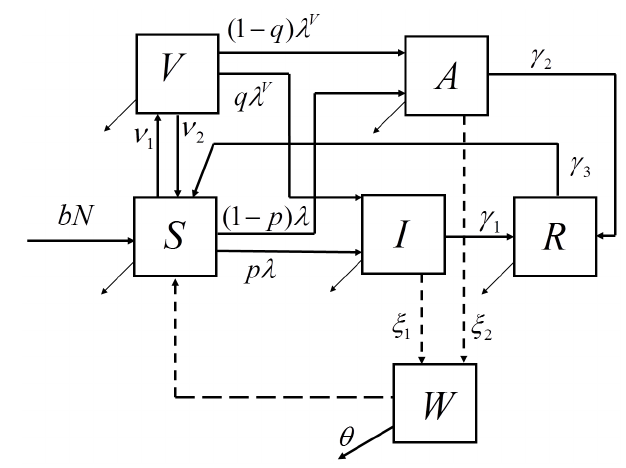
Figure 1. Flow diagram of the mathematical model of cholera transmission. Individuals are aggregated in compartments by cholera status as susceptible unvaccinated (S), susceptible vaccinated (V), cholera cases (I), asymptomatically infected (A), and recovered (R). The concentration of Vibrio cholerae in the environment is tracked in a separate compartment (W). Proportion p of the susceptibles and proportion q of the vaccinated who become infected are symptomatic (cholera cases), and a fraction r of these are reported and used to fit the model to surveillance data. Infected individuals shed bacteria into the environment and cause indirect transmission of Cholera (dashed lines). The simulated population is additionally stratified by age (not shown). A complete description of the model including the expressions for the forces of infections ( l and l V ) is presented in Text S1.